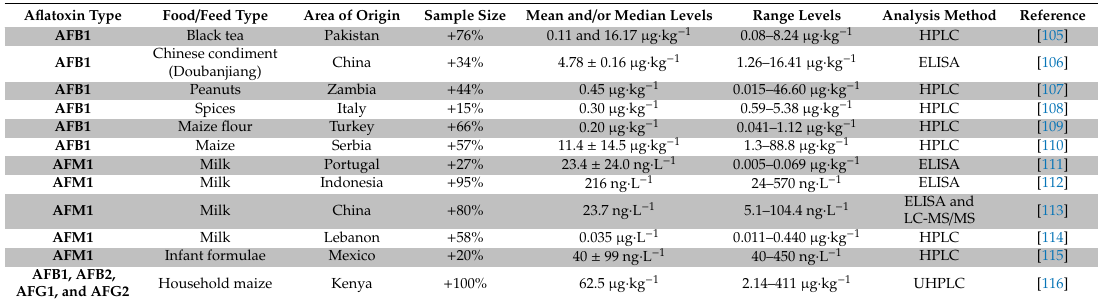
Table 1. Prevalence and levels of aflatoxins in di ff erent foods from di ff erent countries.